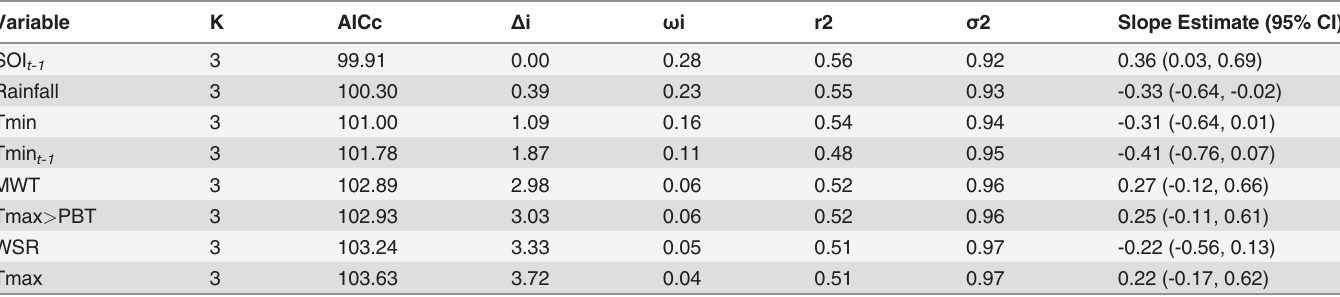
ω 2 = regression i ) = AIC weight, r